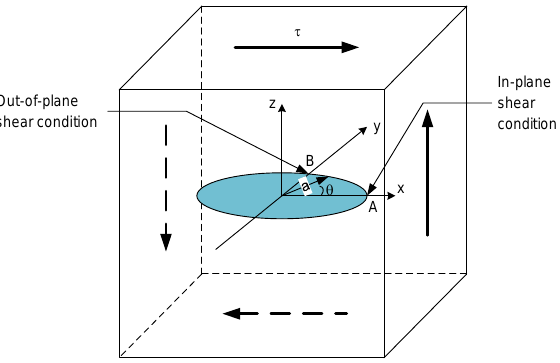
Figure 16. Penny-shaped crack in an infinite medium under shear stresses.